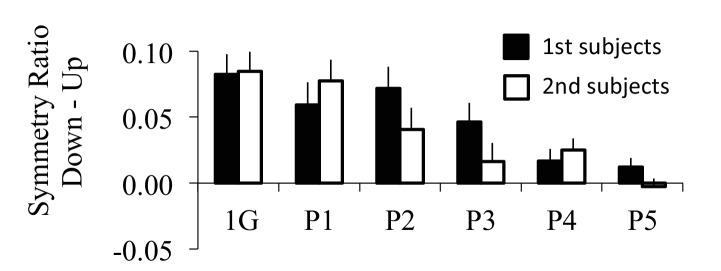
Supplemental analysis on the effect of subject order during the microgravity experiment.Because two subjects were successively tested during each parabolic flight, the second subject to be tested had therefore already been submitted to microgravity during the test period of the first subject. To reduce sensorimotor adaptation before the experiment was performed for the second subject, we restrained this subject on the ground and prevented him from moving his body limbs. Our rationale was that preventing motor interaction with the various unwanted gravito-inertial force fields would reduce sensorimotor adaptation. Vertical bars represent the directional difference (Down-Up) between average symmetry ratios for subjects who performed the experiment first (black filled bars) and those who performed the experiment second (black open bars) in one-G and during zero-G (P1 to P5) environments. Subjects in both groups exhibited similar behavior (Kruskal-Wallis ANOVA: H1,11<2.13 and p>0.14 in all cases); i.e. directional asymmetry was present during the first parabola and then progressively disappeared.